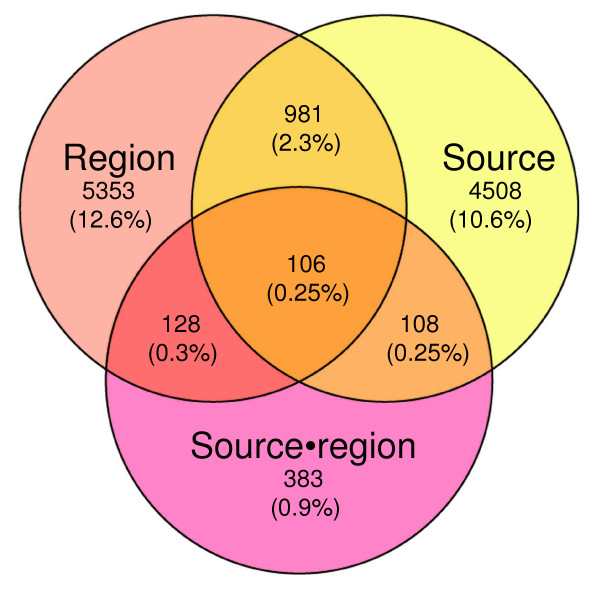
ANOVA test results. Numbers indicate number of probe sets with expression significantly influenced by brain region, source of sample material, and their interaction. The interaction term is significant when the expression changes due to death differ significantly in the two brain regions examined (see Material and methods). Numbers in brackets indicate the percentage of significant probe sets compared to the total number included in the analysis. Overlapping regions include probe sets with more than one significant term.